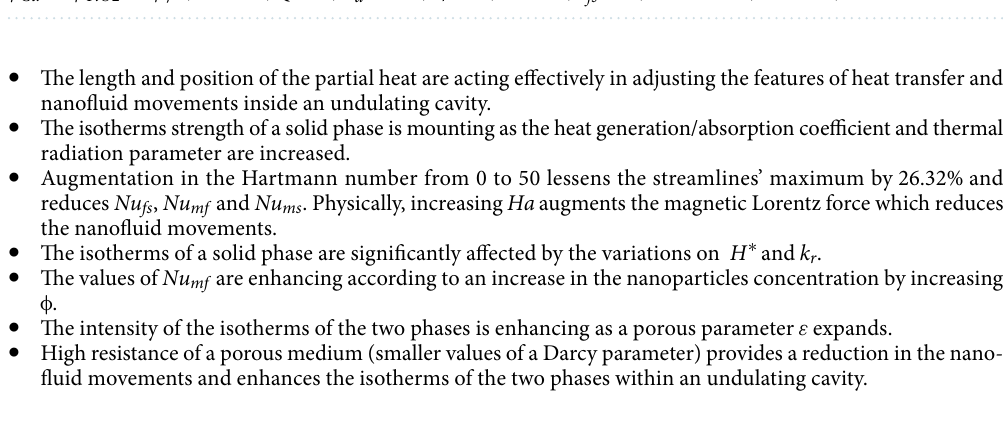
Figure 24. Variation of Nu mf below the changes on a heat source position D for a hybrid nanofluid at φ Cu = φ TiO 2 = φ/ 2, B = 0.5, Q = 1, R d = 0.5, k r = 1, ε = 0.5, k fs = 1, Da = 10 − 3 , H ∗ = 10, Ha = 10